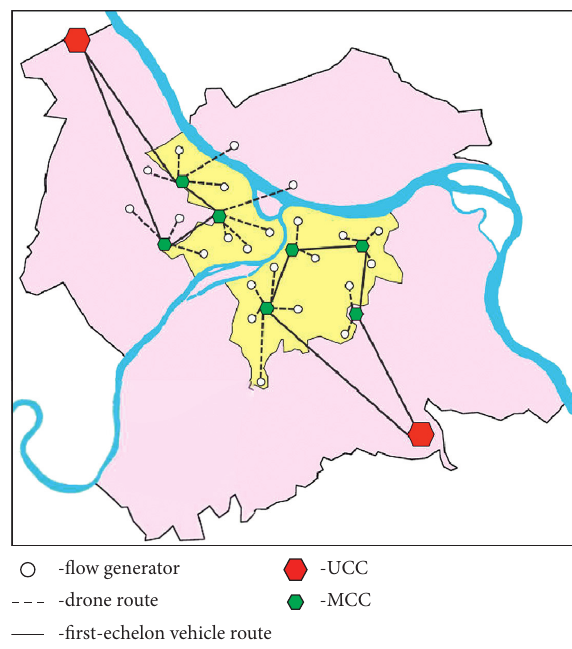
Figure 3: CL concept 3: two-echelon goods delivery with MCCs and